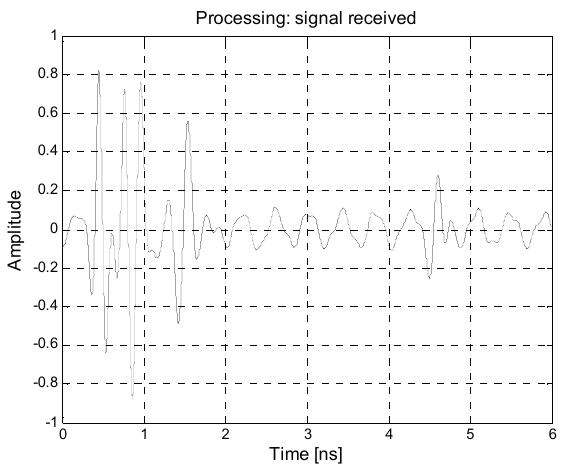
Figure 24. Example of received waveform in the presence of external EMI sources.